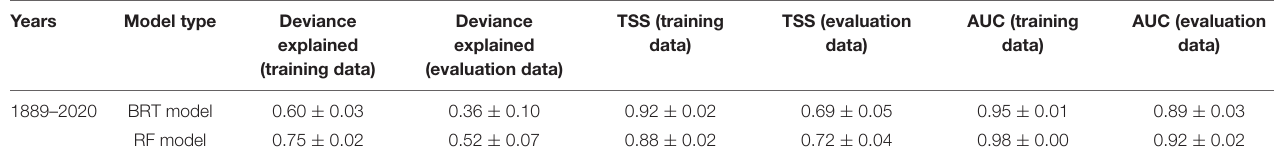
TABLE 2 | Mean cross-validated estimates of model performance for the bootstrapped boosted regression tree (BRT) and random forest (RF) models (time series